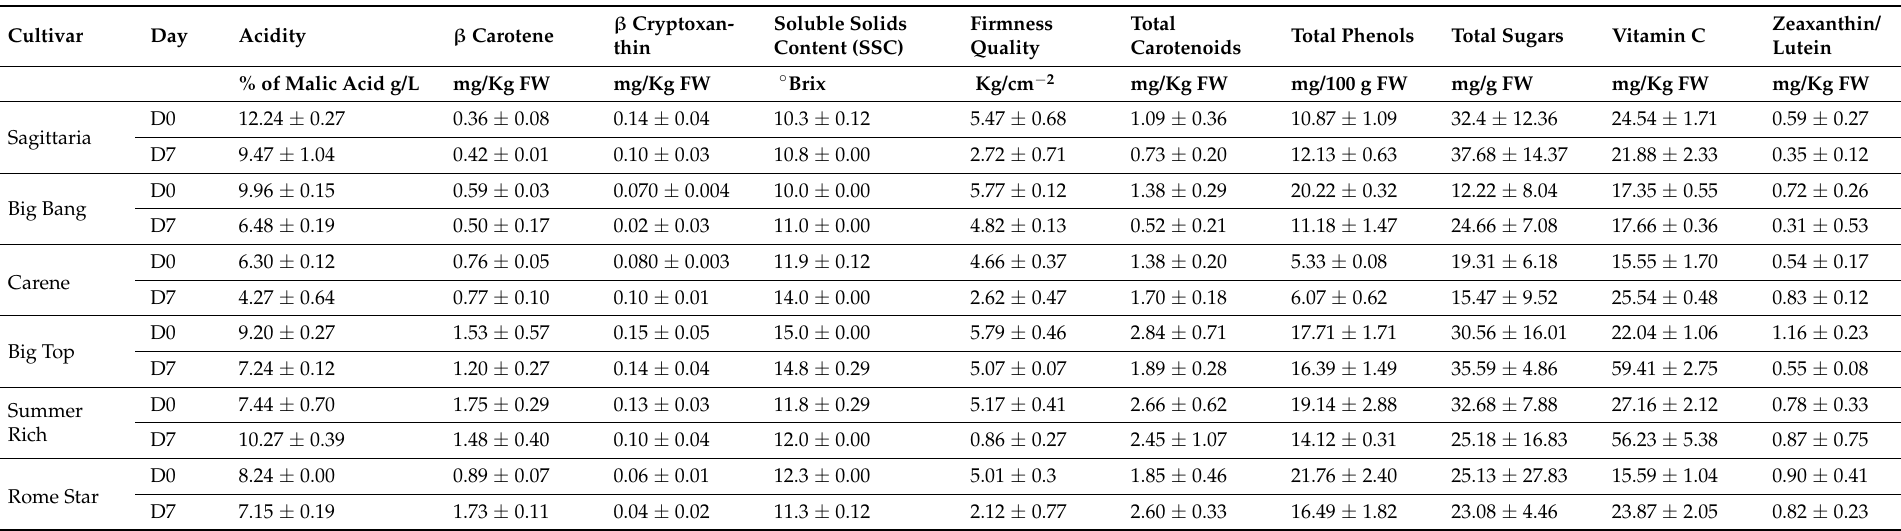
Table 1. Peach intrinsic quality characters broken down by cultivar and storage treatment.